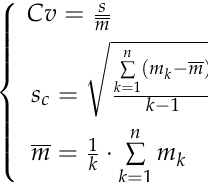
( c ) Figure 9. The influence curve of the single factor test. ( a ) Effect of angle on the transversal fertilizer uniformity coefficient and longitudinal fertilizer uniformity coefficient, ( b ) effect of width on the